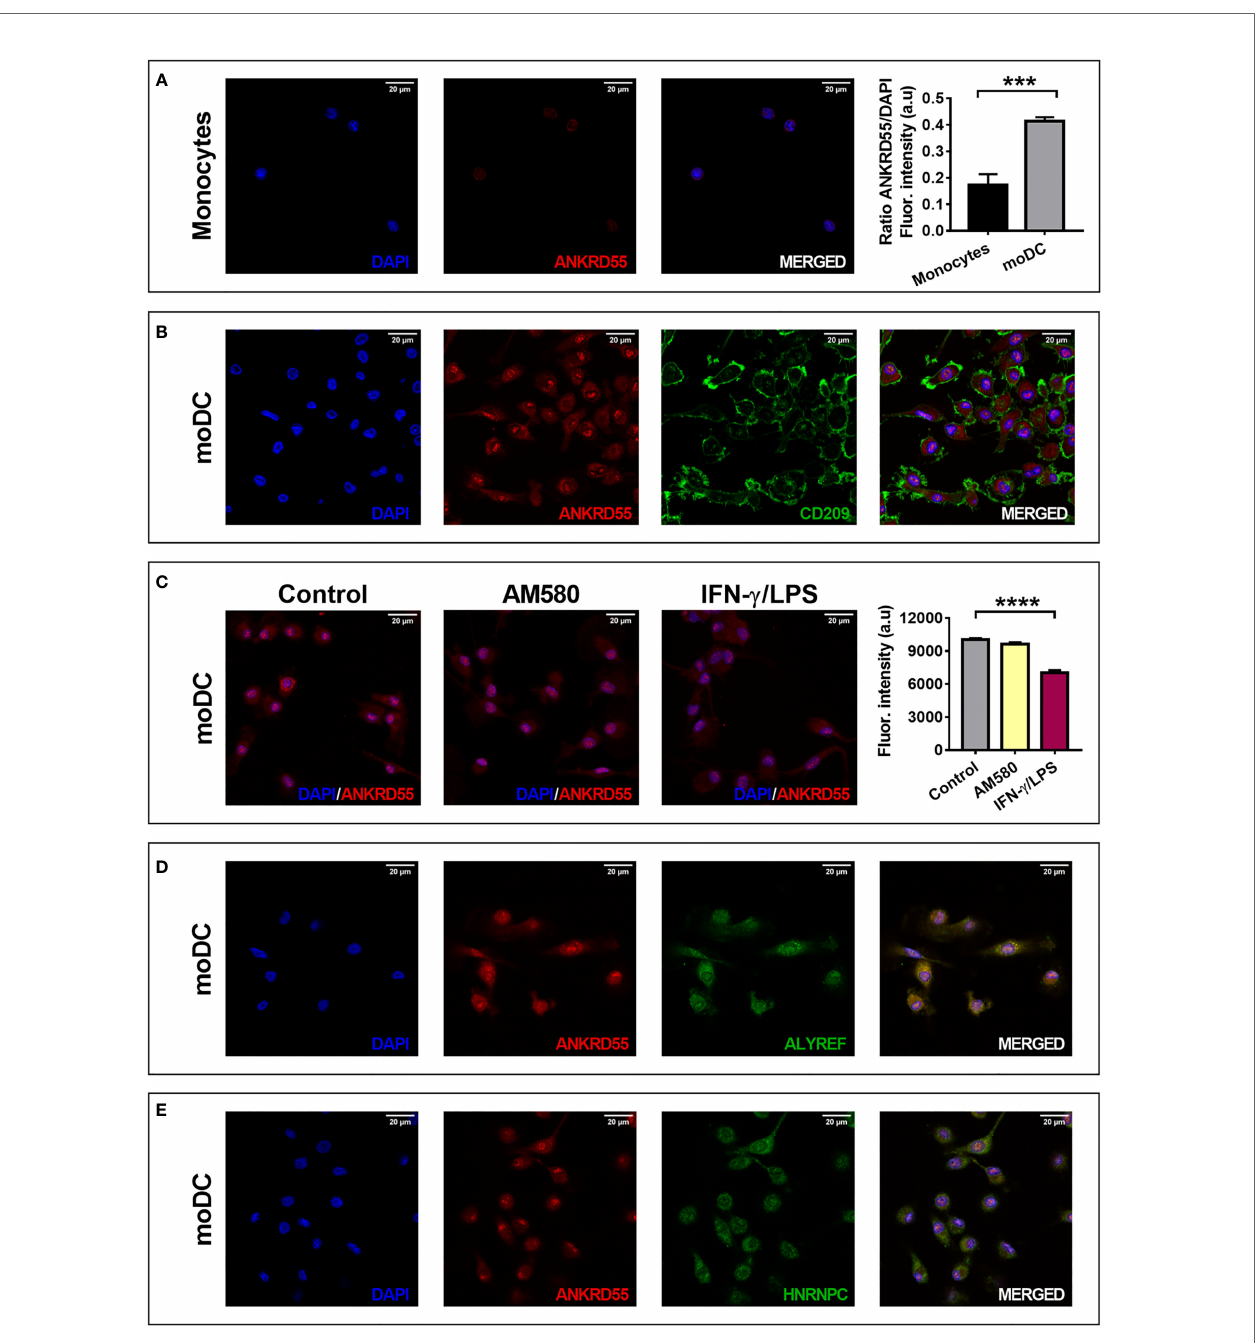
FIGURE 4 | Localization of ANKRD55 in (A) monocytes (1.024 × 1.024 pixels = 0.131 microns/pixel) and (B – E) moDC by immuno fl uorescence microscopy. Rightmost graph represents mean ± SEM in monocytes and immature moDC ( n = 5 cellular ROIs/group; unpaired t -test). (B) Colocalization of ANKRD55 with CD209, a membrane marker speci fi c for moDC (2.048 × 2.048 pixels = 0.065 microns/pixel). (C) Effect of AM580 and IFN- g /LPS treatment on nuclear ANKRD55 signal in immuno fl uorescence (1,808 × 1,808 pixels = 0,074 microns/pixel). The diagram on the right provides quantitative analysis of nuclear ANKRD55 immuno fl uorescence [mean ± SEM; n ≥ 59 cellular ROIs/condition; Kruskal – Wallis test (followed by Dunn ’ s multiple comparison test)]. (D) Colocalization of ANKRD55 with ALYREF (1.024 × 1.024 pixels = 0.131 microns/pixel). (E) Colocalization of ANKRD55 with HNRNPC (1.024 × 1.024 pixels = 0.131 microns/pixel). *** p ≤ 0.001, **** p ≤